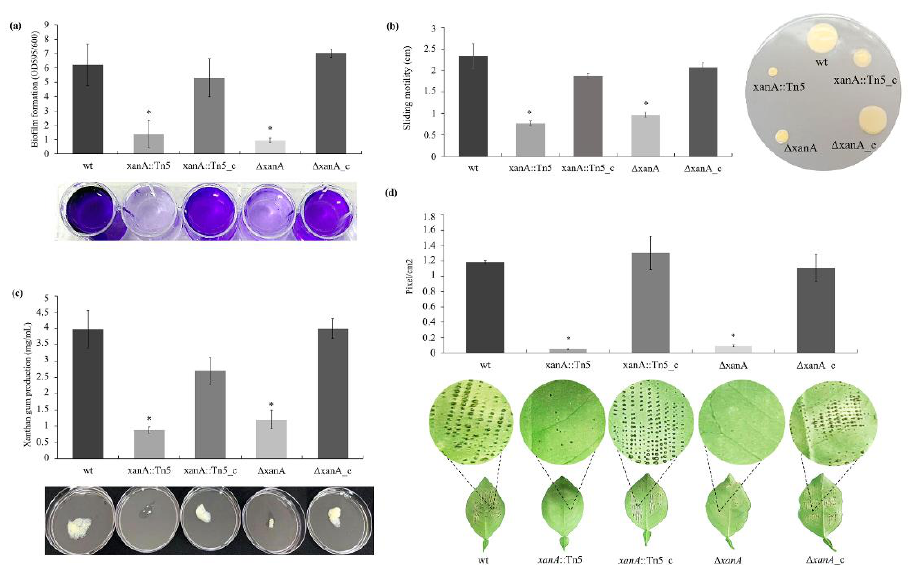
Figure 3. Biofilm, sliding motility, xanthan gum production, and pathogenicity of X. citri strains. ( a ) Biofilm formation on polystyrene surface. Values are expressed as the means ± standard deviations of six independent replicates. ( b ) Sliding motility phenotypes on SB agar medium plates after 48 h of incubation at 28 ◦ C. Values are expressed as the means ± standard deviations of three independent replicates. ( c ) Xanthan gum production by X. citri strains. ( d ) Sweet orange leaves microneedle and inoculated with the different X. citri strains (10 8 CFU/mL). Pictures are representative of five leaves for each strain. wt, wild-type; xanA ::Tn5, transposon mutant; xanA ::Tn5_c, complemented transposon mutant; ∆ xanA , deletion mutant; ∆ xanA _c, complemented deletion mutant. * indicates significant difference by t-test ( p < 0.05) compared with wt strain.